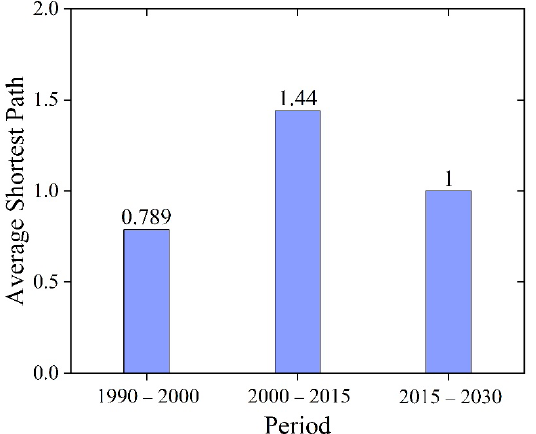
Figure 13. Average shortest path during the different periods.